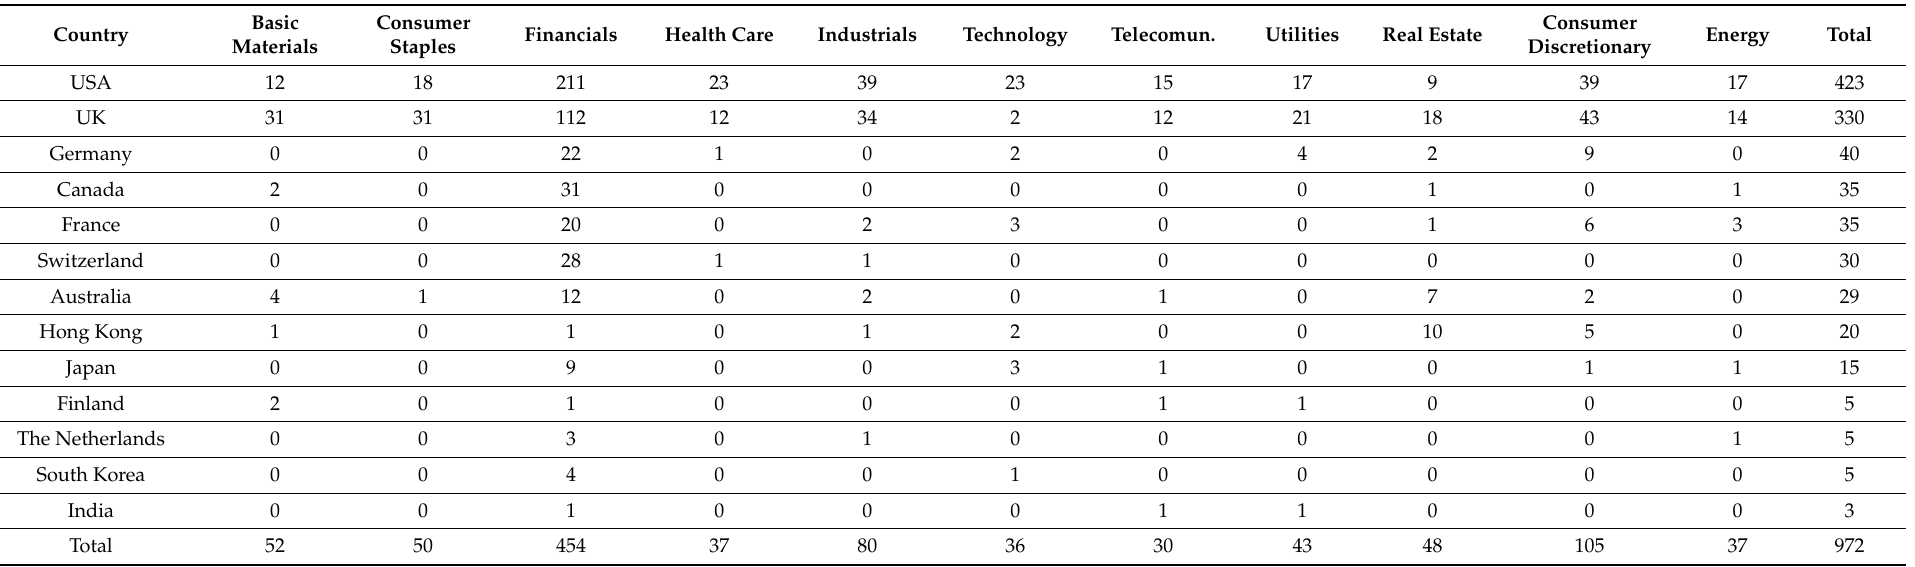
Table 2. Sample distribution by